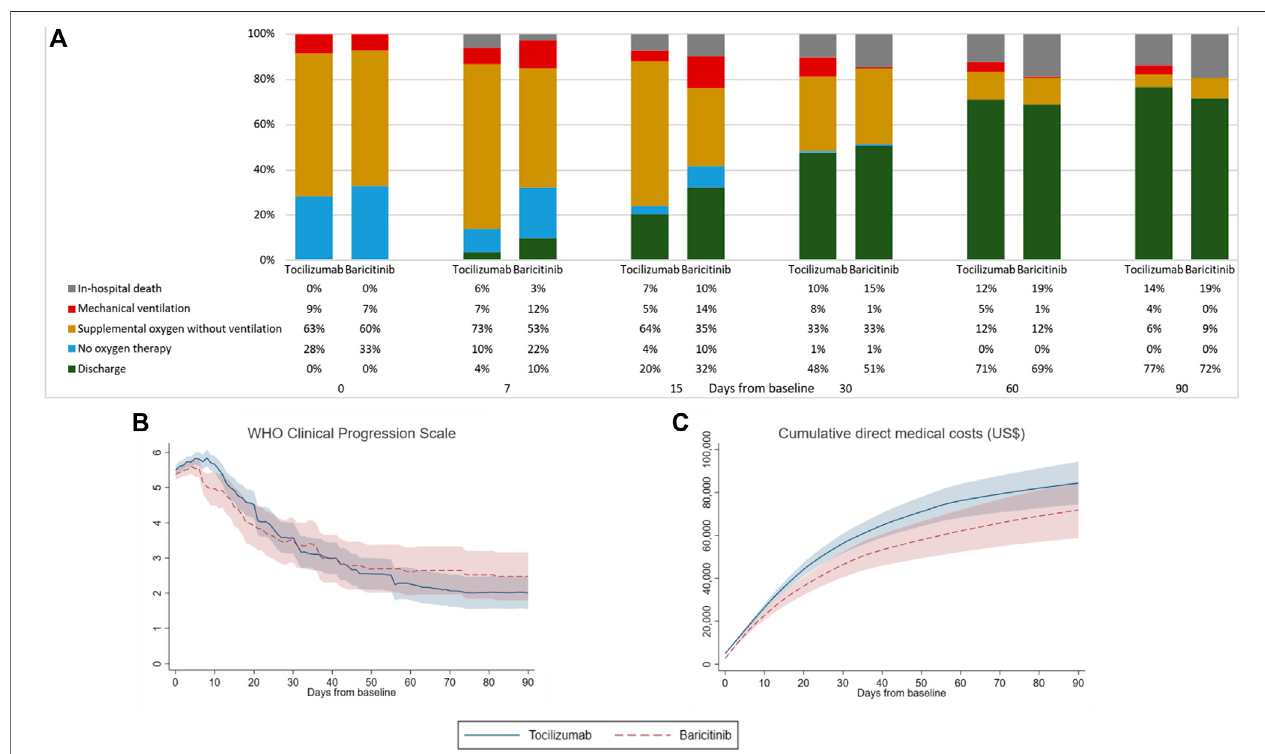
FIGURE 1 | Comparison of (A) clinical status measured by WHO Clinical Progression Scale score, (B) WHO Clinical Progression Scale score, and (C) cumulative direct medical costs incurred by patients of tocilizumab and baricitinib groups from baseline to day-90 of follow-up.